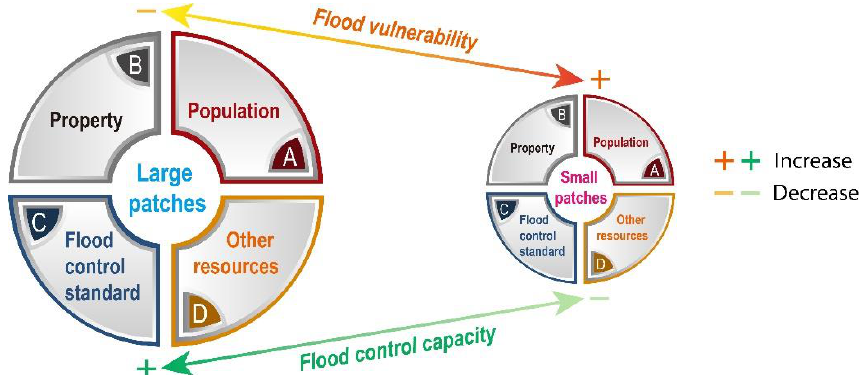
Figure 13. Effects of different patch sizes on flood vulnerability and flood control capacity. Figure 14. E ff ects of di ff erent patch sizes on flood vulnerability and flood control capacity.